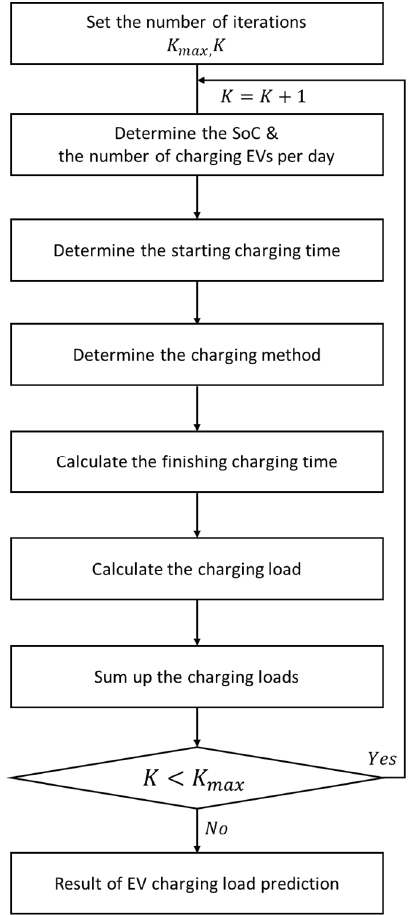
Figure 8. The flowchart of the Monte Carlo Simulation for predicting EV charging load curve.